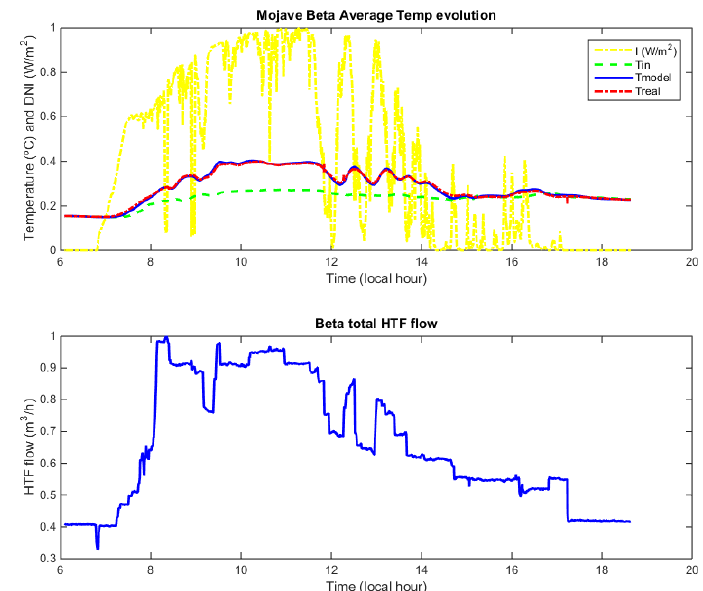
Figure 6. Beta average temperature, model vs. real evolution: ( top ) model (blue solid) and real (red dash-dotted); and ( bottom ) HTF flow.